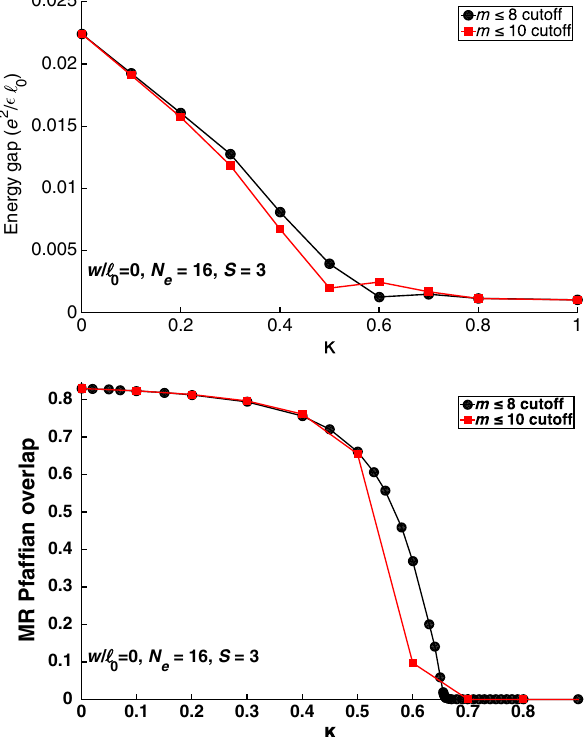
FIG. 18. Top panel: Expectation value of the three-body terms FIG. 19. Top panel: Energy gap (difference between the two in the MR and aPf trial wave functions as a function of angular lowest eigenvalues) calculated at the “ Pfaffian" shift S ¼ 3 in a j H ð m Þj Ψ i where H ð m Þ ¼ momentum m , i.e., h Ψ 3 body 3 body system with 16 electrons. Bottom panel: MR Pfaffian overlap. trial trial P ˆ P V ð 3 Þ m ð w= l ; κ Þ ð m Þ , and Ψ ¼ Ψ or Ψ . Bottom Black data points correspond to the Hamiltonian used in the main 0 ijk i<j<k trial MR aPf panel: Expectation value of the three-body terms for the S ¼ 3 text where only the three-body pseudopotentials V and S ¼ − 1 ideal Coulomb ground states as a function of angular are used. Red data points correspond to the case when also V momentum m . ð 3 Þ and V 10 are